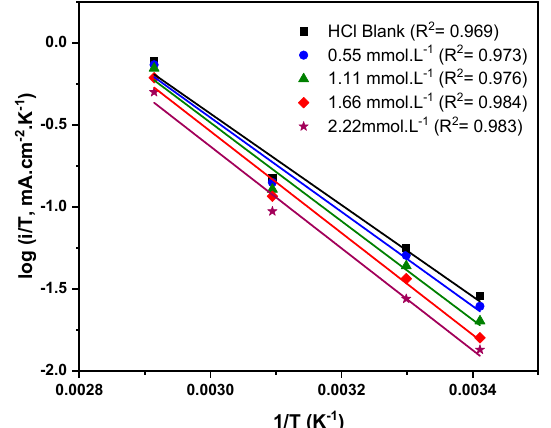
Figure 9. Transition-state plots of log (i/T) versus (1/T) for C-steel at different concentrations of the Q-22 inhibitor in 5 M HCl.